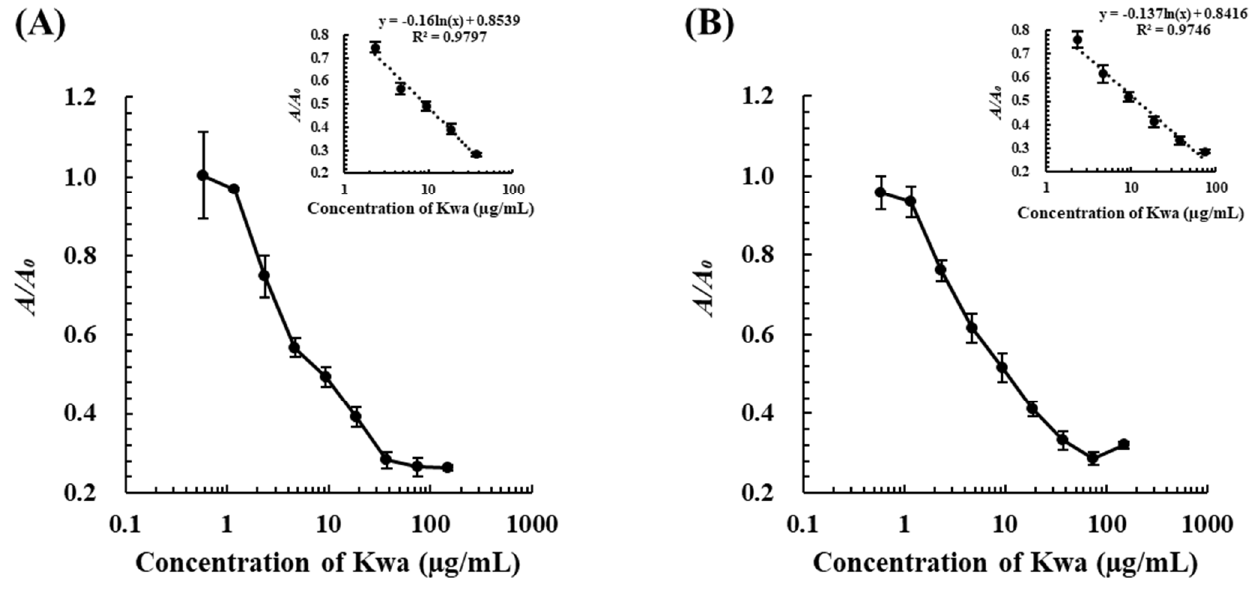
Figure 7. Calibration curves of cELBIA using ( A ) biMAb 2H2 and ( B ) biMAb 1D2. The Kwa-HRP conjugates and biMAbs (biMAb 2H2 and biMAb 1D2) were used at 50 and 225 µ g/mL, respectively. Table 3. The CRs of biMAb 2H2 and biMAb 1D2 against major isoflavones, evaluated by cELBIA. CRs (%) Class Compound biMAb 2H2 Class